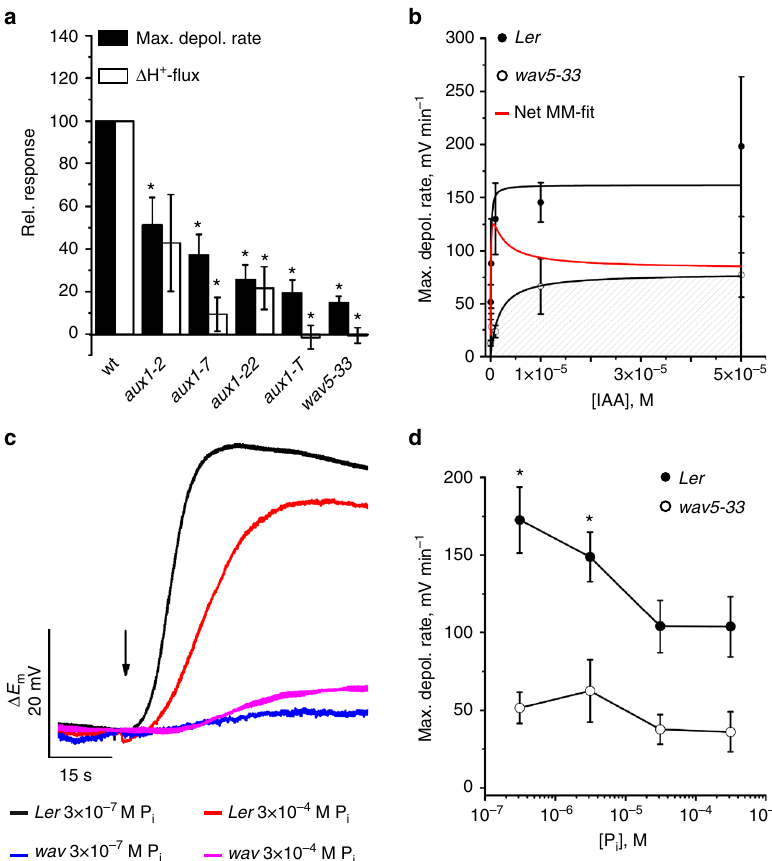
Fig. 2 IAA-induced membrane depolarization and H + -in fl ux are AUX1-dependent. a Maximal depolarization rate and initial change of H + - fl ux, evoked by 10 µ M IAA in wild-type and aux1-2 ( Ler ), aux1-7 ( Col-0 ), aux1-22 ( Col-0 ), aux1-T ( Ws ), and wav5-33 ( Ler ). Values for mutants are given as the percentage of the response of the respective accessions (for mutants n = 10 ± SE for depolarization and n = 12 ± s.e.m. for H + - fl ux, wild-type responses were measured with n = 11 to 13 ± s.e.m.). Asterisks indicate signi fi cant reductions (Students t -test, p < 0.05). b IAA-induced max. depolarization rates, for Ler (closed symbols) and wav5-33 (open symbols). Michaelis – Menten fi ts revealed half-maximal depolarization rates at 67 ± 54 nM for Ler and 1.7 ± 1.6 µ M for wav5- 33 . Note that K m values were calculated from undiluted auxin concentrations inside application pipettes. Differential values of both black curves (red curve) point to a dominant AUX1-dependent uptake at [IAA] below 10 − 6 M, whereas unspeci fi c transporters contribute at higher IAA-levels ( Ler n = 6 to 8 ±